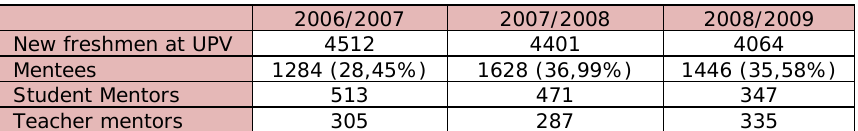
Table 1. “Participation in the PATU program in the period 2005-2009”. Source: